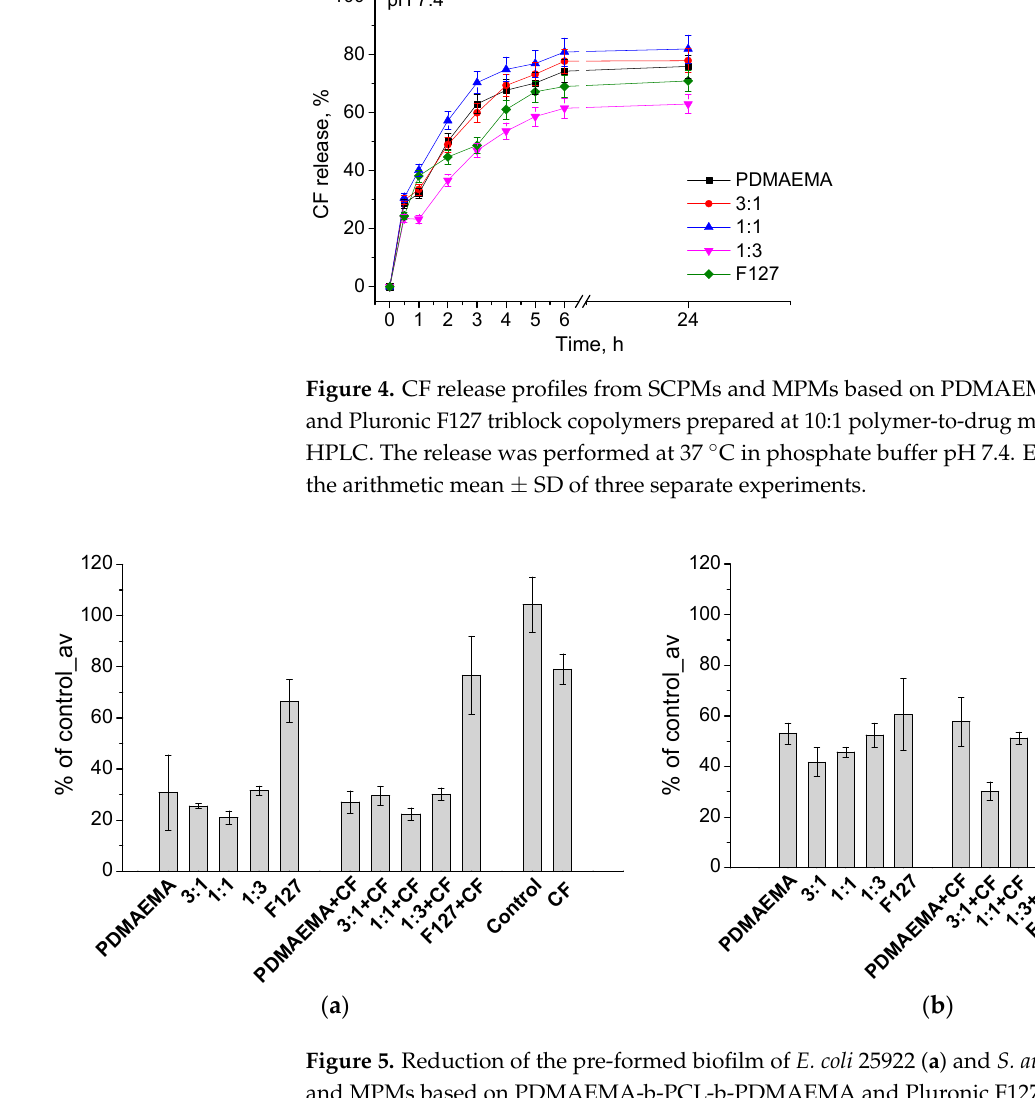
Figure 5. Reduction of the pre-formed biofilm of E. coli 25922 ( a ) and S. aureus 29213 ( b ) by SCPMs and MPMs based on PDMAEMA-b-PCL-b-PDMAEMA and Pluronic F127 triblock copolymers.